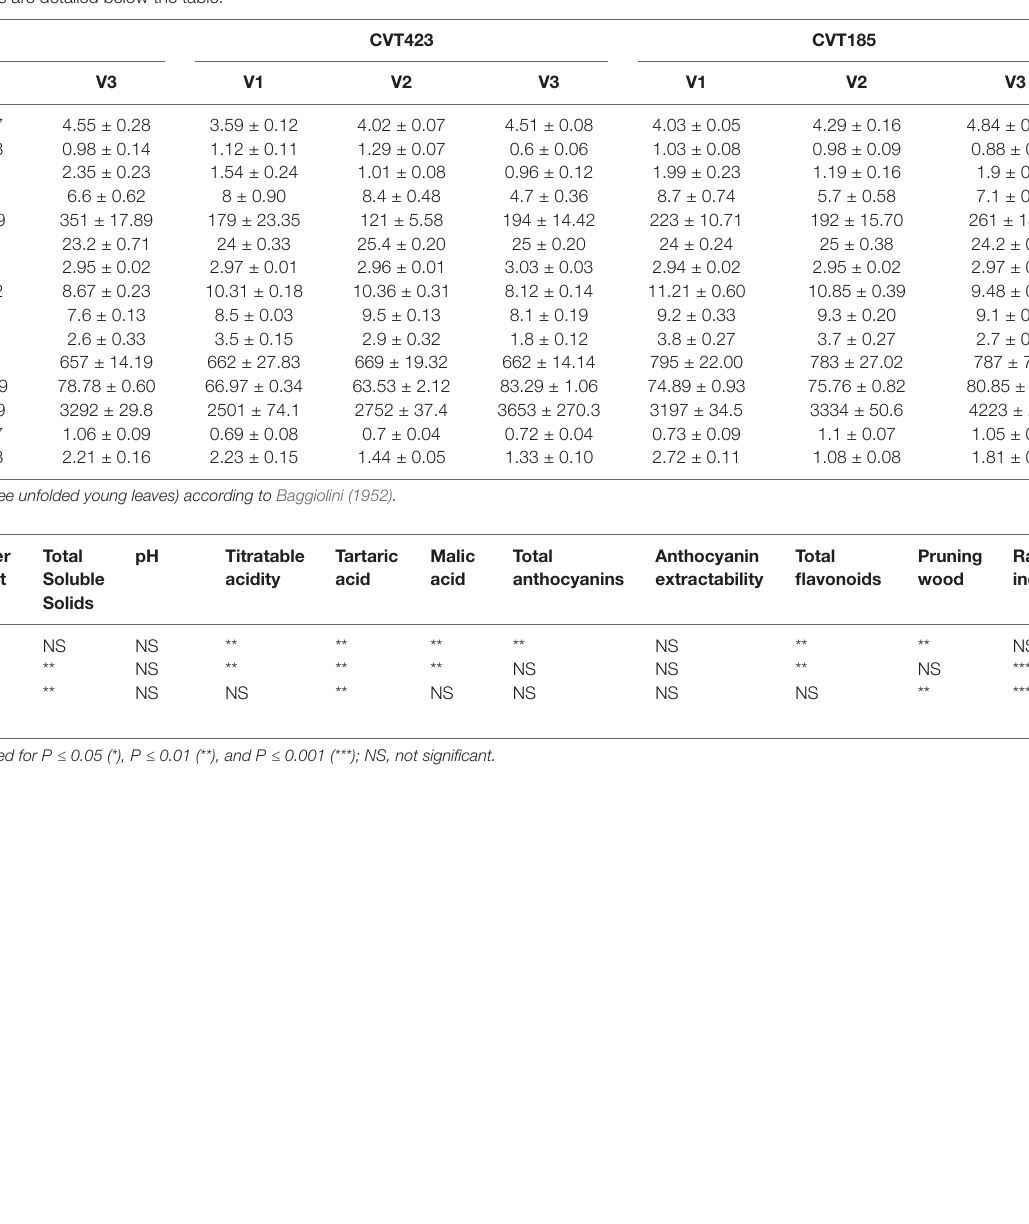
TABlE 1 | Measurements of agronomical parameters, quantity and quality features of the studied ‘Nebbiolo’ clones (CVT71, CVT423 and CVT185) grown in three different vineyards of the Langhe area (V1, V2, V3) in 2013. Data are means ± standard error (n = 21). Results of ANOVA analysis are detailed below the